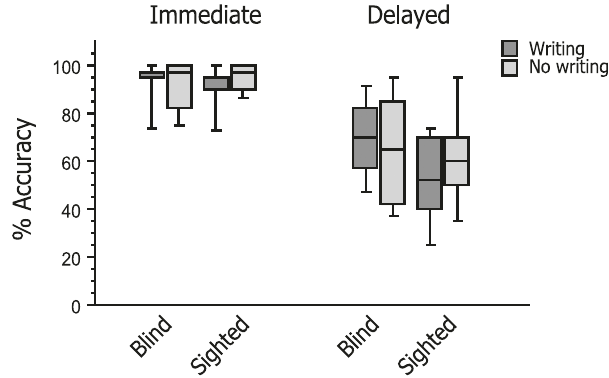
Fig. 2 Behavioral results during the test period. During immediate recall in the MRI scanner, blind and sighted participants identi fi ed FL word meanings with high accuracy (>90%) irrespective of the learning conditions. On delayed recall, however, blind participants tended to score higher in the writing than in the no-writing condition, whereas sighted participants showed an opposite trend between the writing and no-writing conditions. The differential impact of writing was con fi rmed as a robust interaction between the effects of condition and group (see “ Results ” ). In this and all subsequent fi gures, box plot elements are de fi ned as follows: center line, median; box limits, upper and lower quartiles; whiskers, 1.5× interquartile